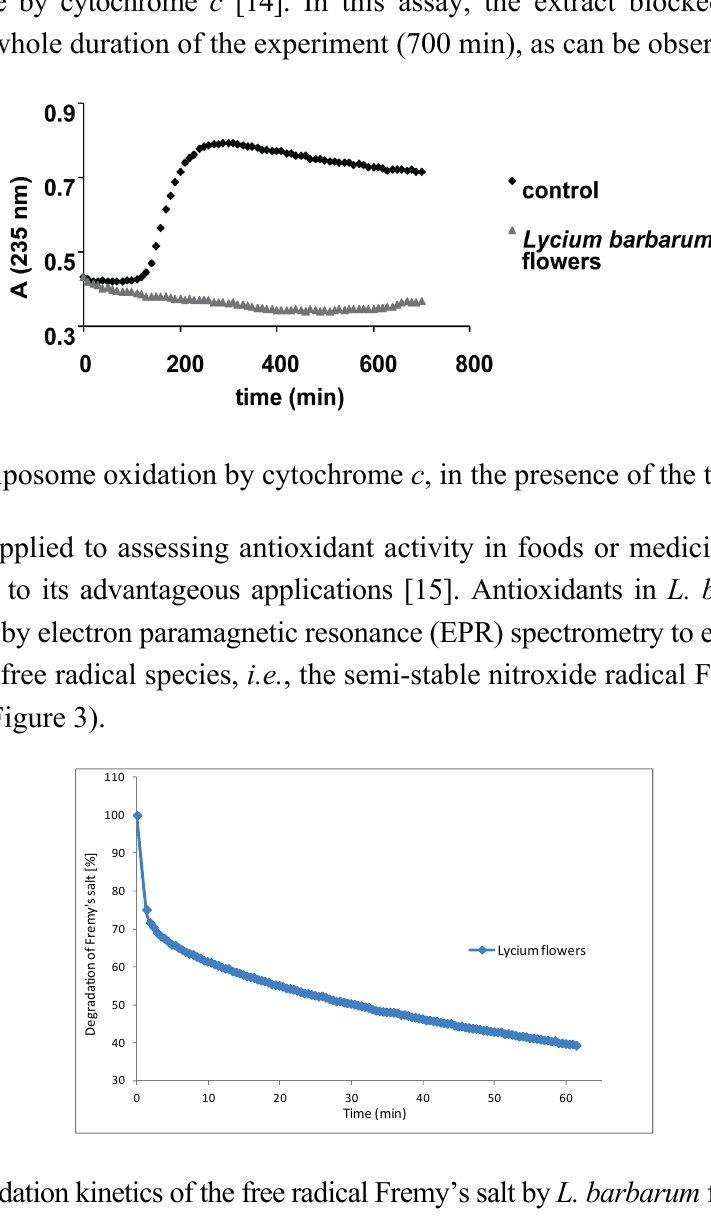
Figure 3. Degradation kinetics of the free radical Fremy’s salt by L. barbarum flowers extract. Information about antioxidant activity of L. barbarum flowers, using the EPR spectrometry assay,